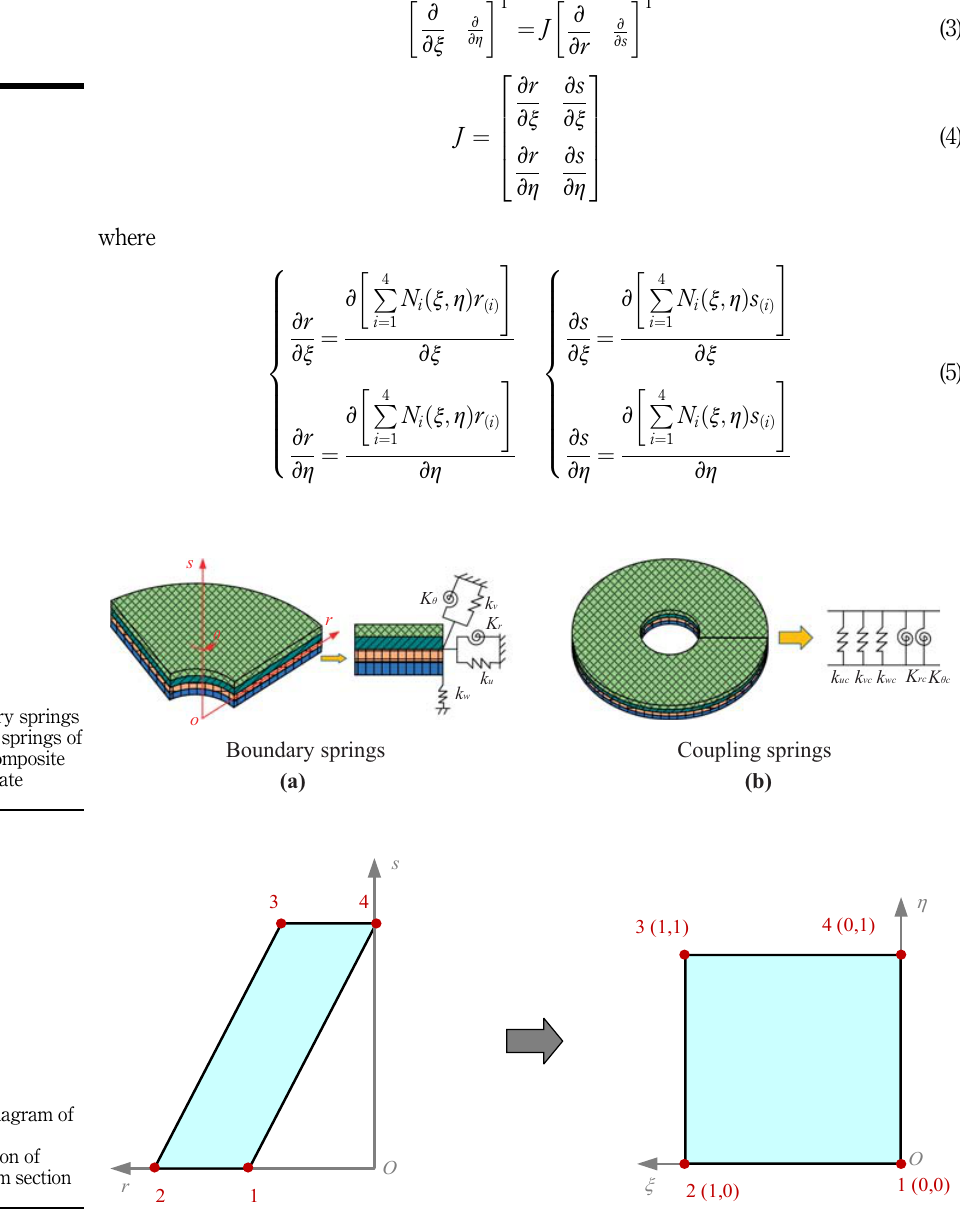
Figure 4. Schematic diagram of coordinate transformation of parallelogram